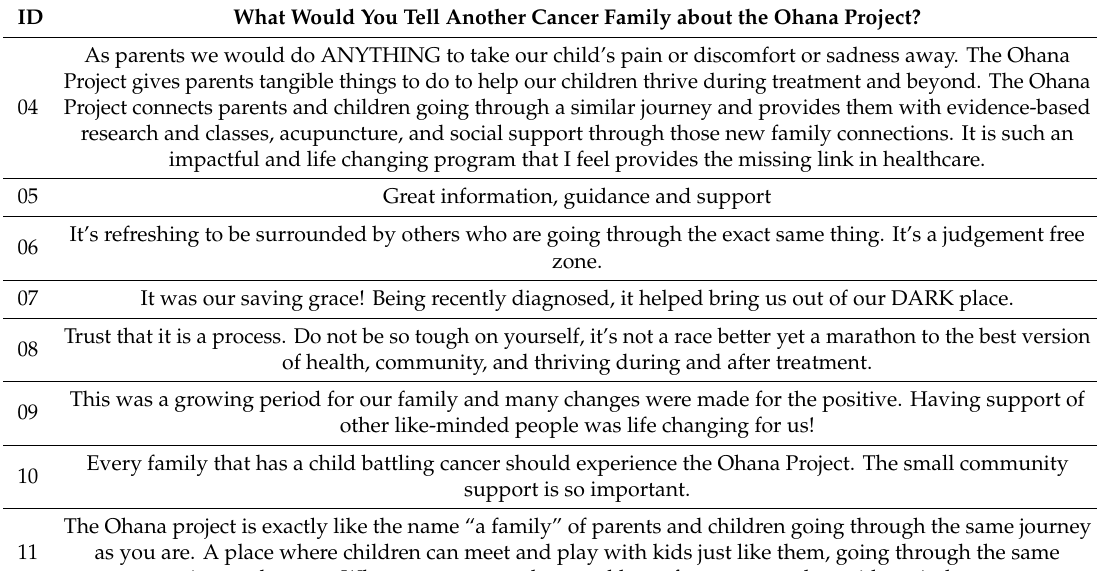
Figure 4. Changes in T-scores for exploratory outcomes for pediatric brain tumor patients.